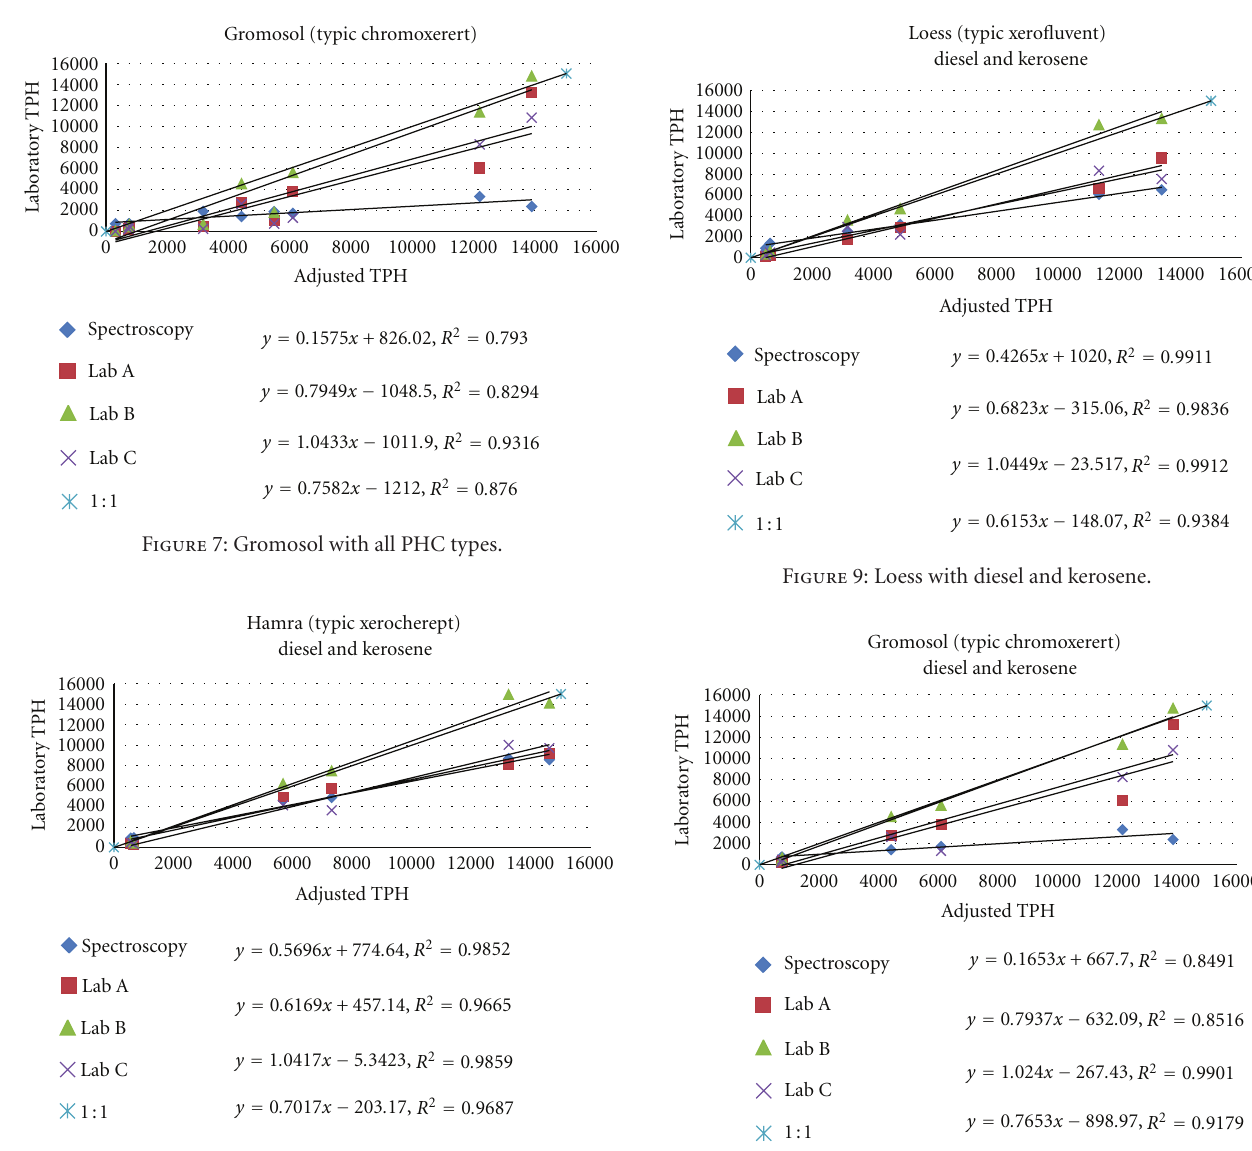
Figure 8: Hamra with diesel and kerosene.